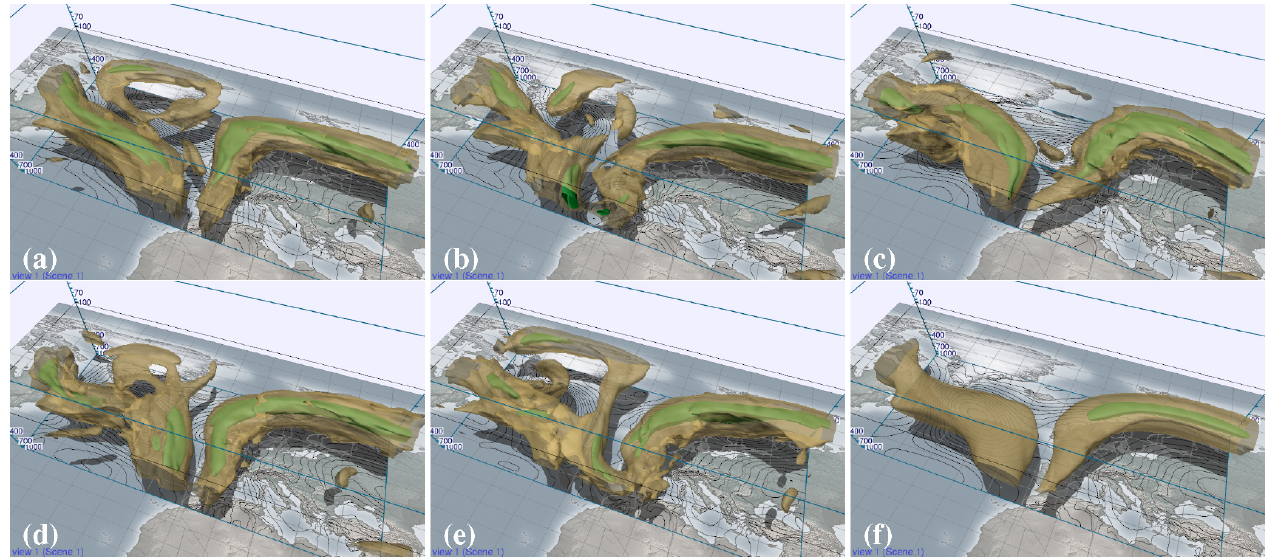
Figure 11. Navigation through the ensemble. Members (a) 27, (b) 33, (c) 37, (d) 43, (e) 45 and (f) the ensemble mean of horizontal wind speed (forecast from 00:00UTC, 15 October valid at 18:00UTC, 19 October 2012). Shown are the 50ms − 1 (green opaque) and 30ms − 1 (yellow transparent) isosurfaces. Black contour lines show sea level